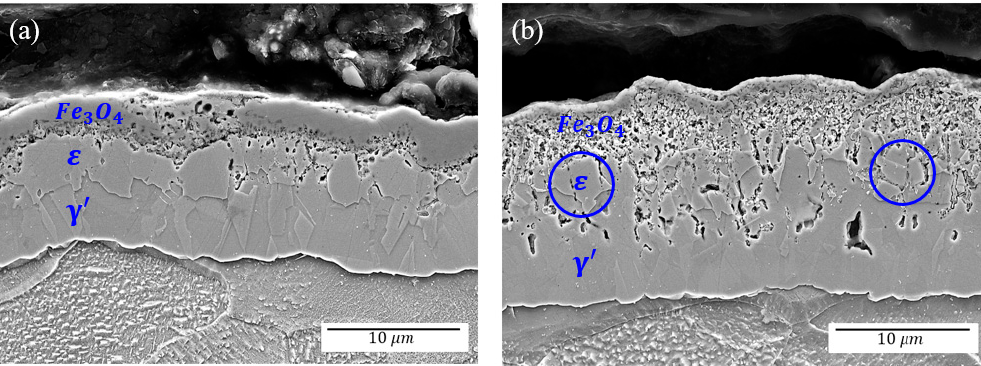
Figure 2. SEM images of surface hardened layer: ( a ) air-specimen and ( b ) steam-specimen.